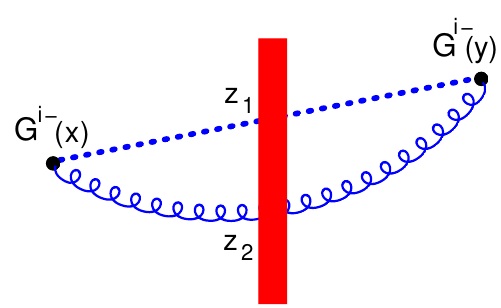
Figure 2 . Diagrams for the impact factors for the quasi-PDFs operators. The black bullets represent the gluons and quark fields